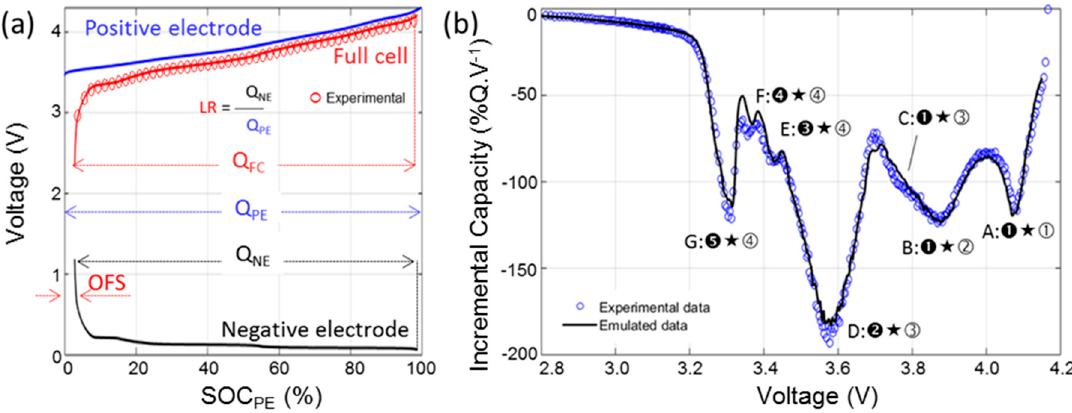
Figure 6. ( a ) Cell architecture emulated in the 'Alawa toolbox; and ( b ) comparison of the IC curves of the experimental and emulated cells at a C/35 rate.